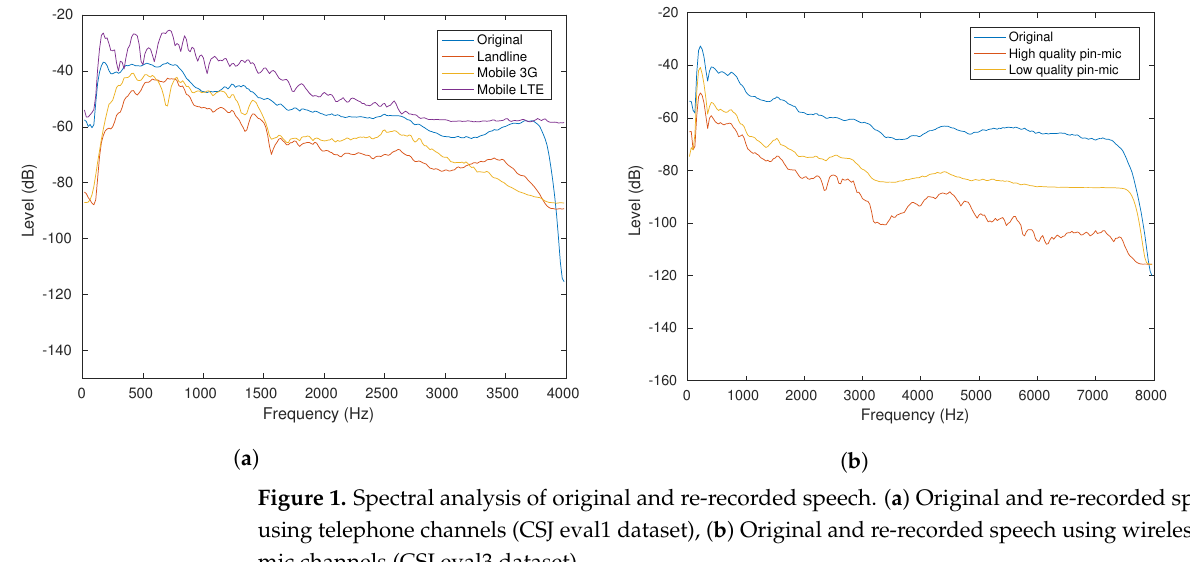
Figure 1. Spectral analysis of original and re-recorded speech. ( a ) Original and re-recorded speech using telephone channels (CSJ eval1 dataset), ( b ) Original and re-recorded speech using wireless pin mic channels (CSJ eval3 dataset).